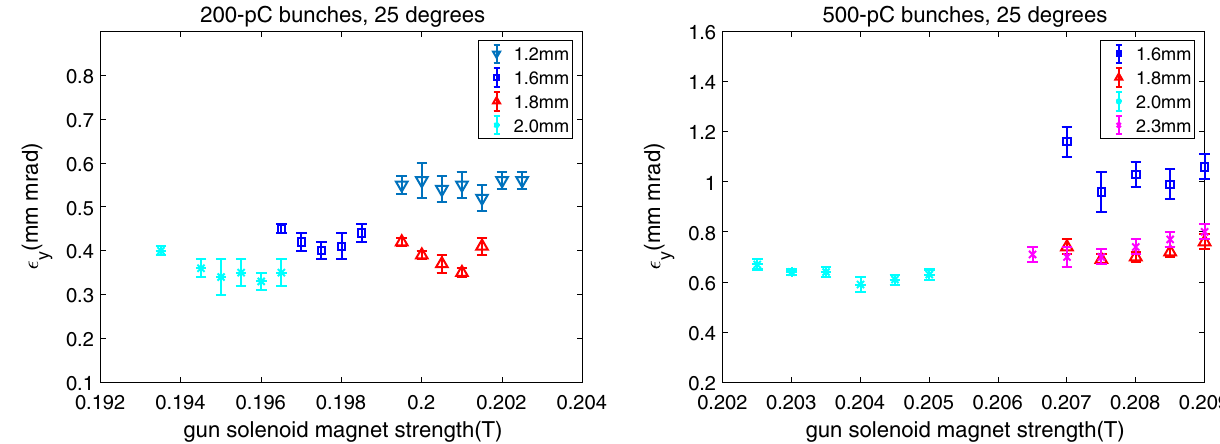
FIG. 13. The change in emittance of 200-pC and 500-pC bunches with different laser spot sizes as a function of gun solenoid magnet gradient. The launch phase is 25